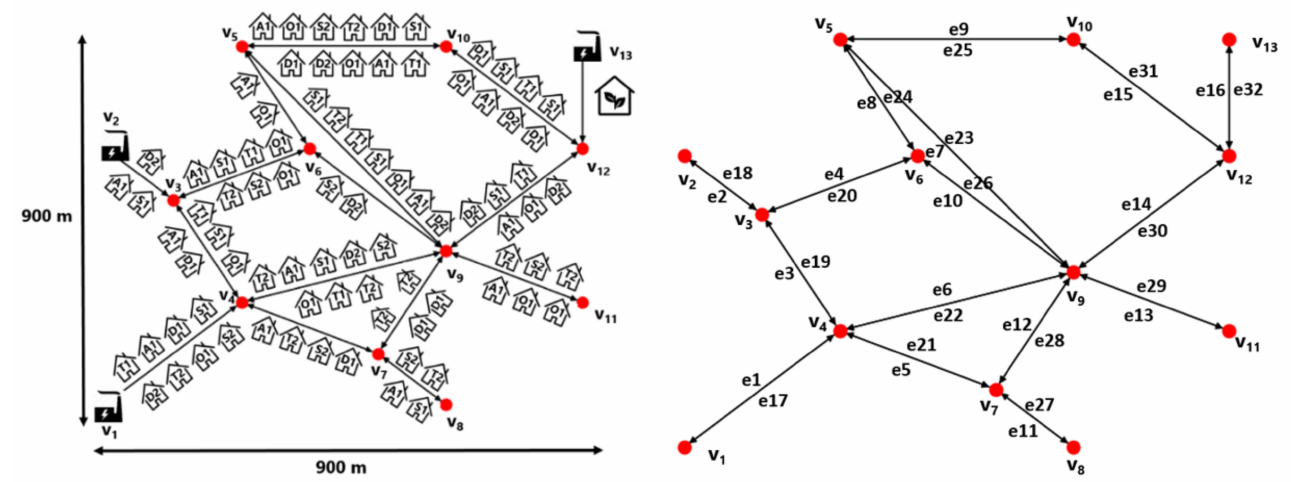
Figure 2. Graph representation of a neighborhood of 16 streets with 13 intersections.